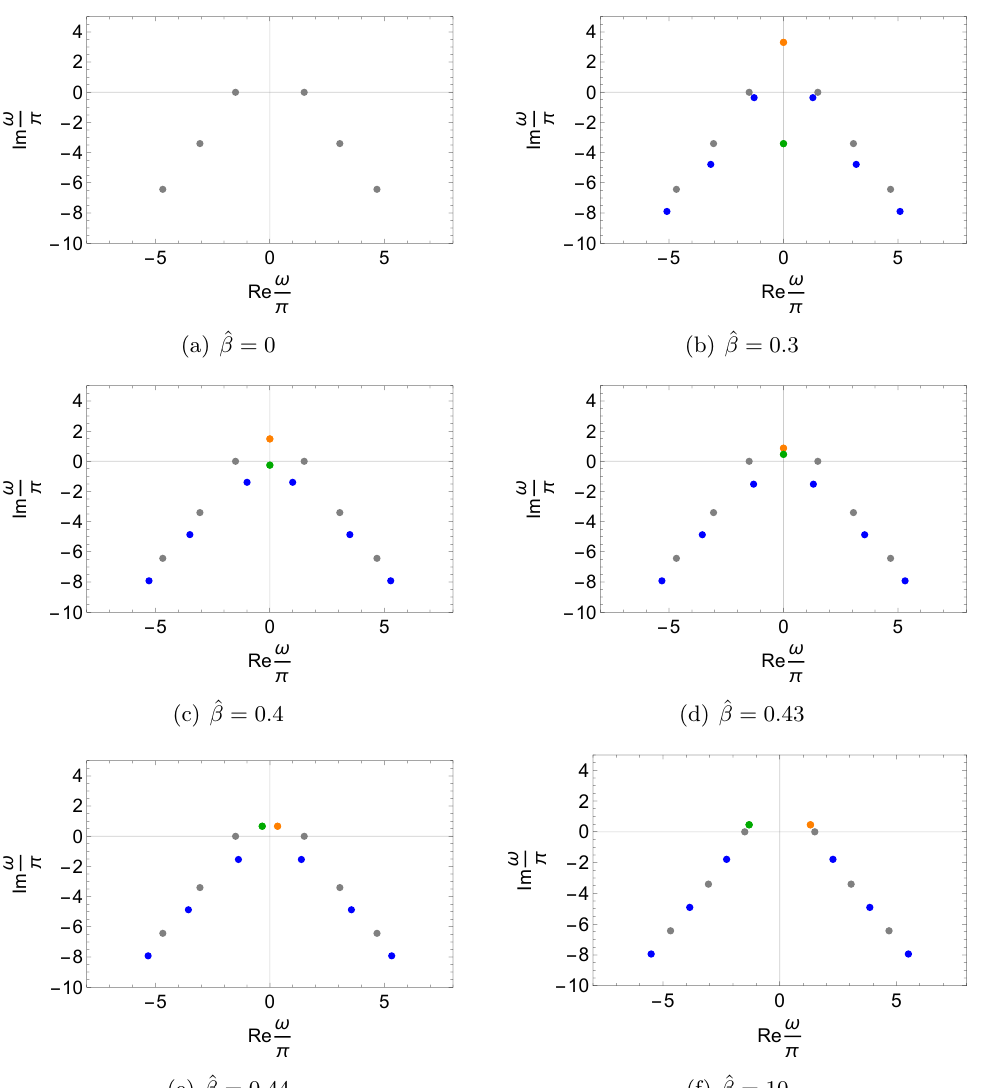
Figure 10 . Behavior of first 8 QNMs in complex frequency plane with varying ˆ β for k = 1 . 5 . The dots in gray represent the k = 0 poles in all the figures. The pair of poles just below the horizontal axis on the lower half plane are the diffusion and quasi-hydro poles. It is obvious that these are the smooth deformations of the ω = ± k poles of χ in the decoupling limit. The orange pole is ω U and the green pole is ω G . We readily observe that just as in the case of k = 0 , the poles attain finite values as ˆ β → ∞ and realign approximately on the same straight line, and (except for the two unstable poles in the upper half plane) are halfway in between the poles in the decoupling